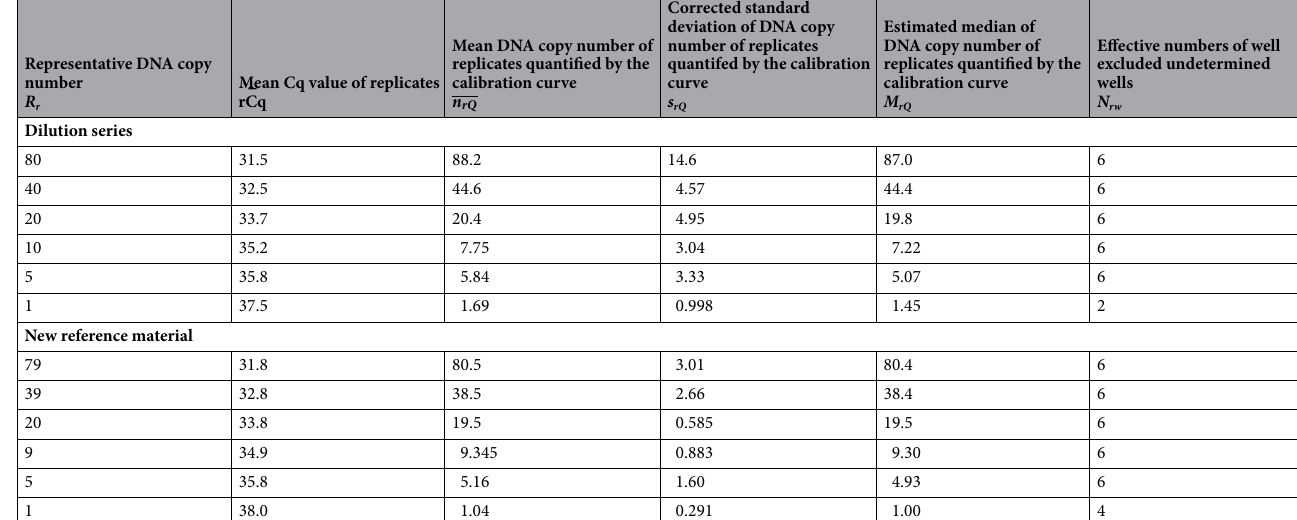
Table 3. Real-time PCR results of calibrators.